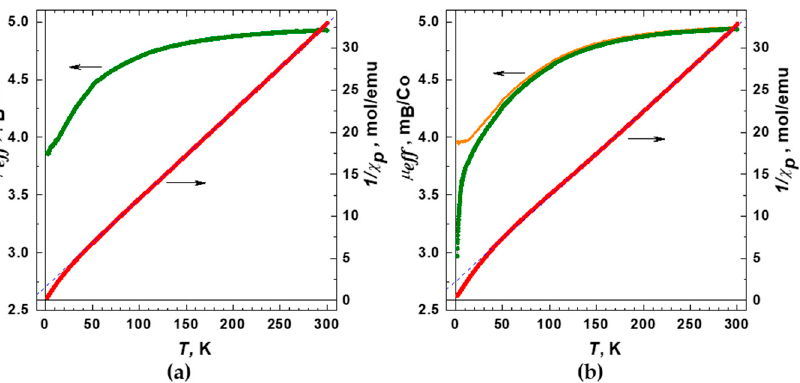
Figure 8. Temperature dependences of the reciprocal magnetic susceptibility 1/ χ p (paramagnetic component) and effective magnetic moment μ eff per one cobalt ion for the compound: ( a ) 1 ; ( b ) 2 . Dashed blue lines indicate formal Curie–Weiss fits for the high-temperature region. The orange curve in plot ( b ) shows the μ eff data obtained by taking into account the antiferromagnetic intermolecular interactions. Magnetic field 10 3 Oe.